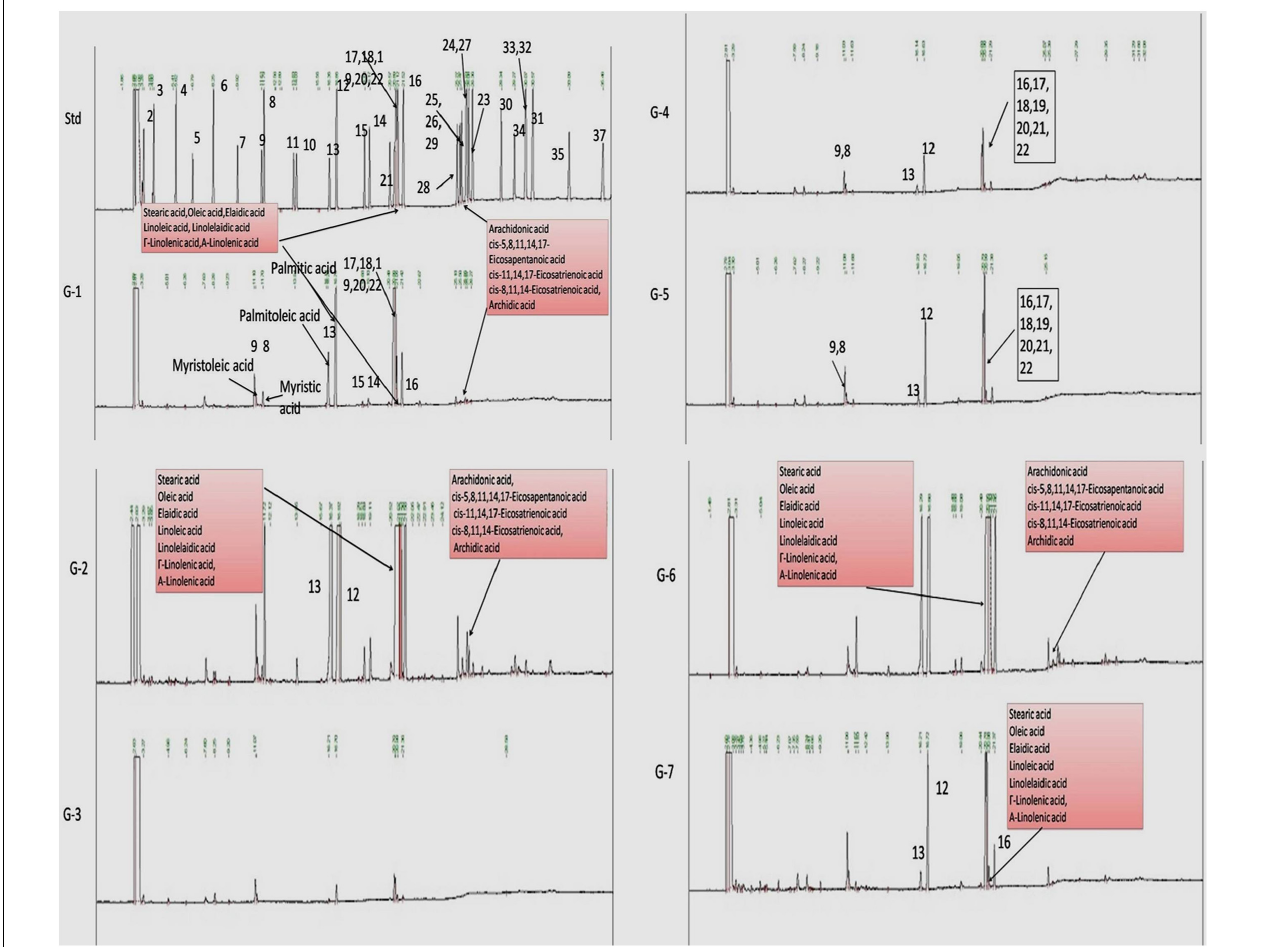
FIGURE 5 | Effect of VOA and VIN on fatty acid composition of mammary gland tissue. Std, standard (Supelco FAME 37 component, Sigma-Aldrich); NC, normal control (saline 2 ml/kg); G2, toxic control (DMBA 8 mg/kg, i.v.); G3, voacamine (VOA) (1 mg/kg, s.c.); G4, vincristine (VIN) (1 mg/kg, i.v.); G5, VOA (0.5 mg/kg, s.c.) + VIN (0.5 mg/kg, i.v.); G6, VOA (1 mg/kg, s.c.) + VIN (1 mg/kg, i.v.); and G7, DC-DMSO 3% (2